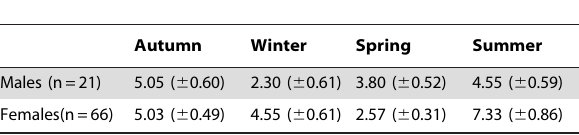
Autumn Winter Spring